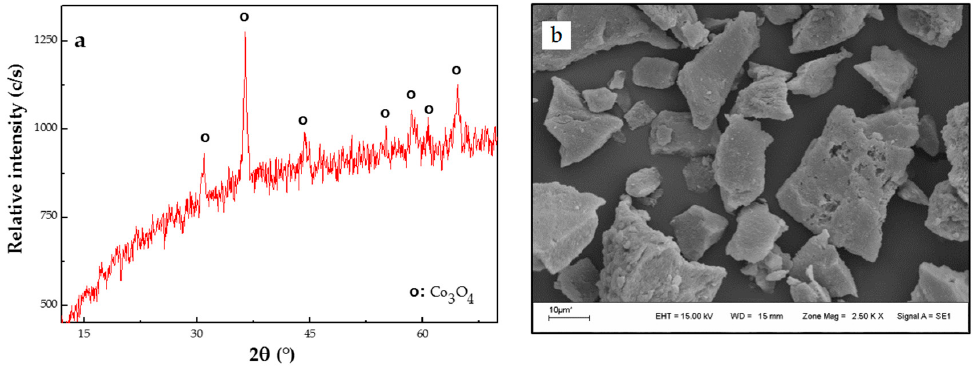
Figure 10. ( a ) XRD and ( b ) SEM of the precipitated solid by the addition of NaOH.